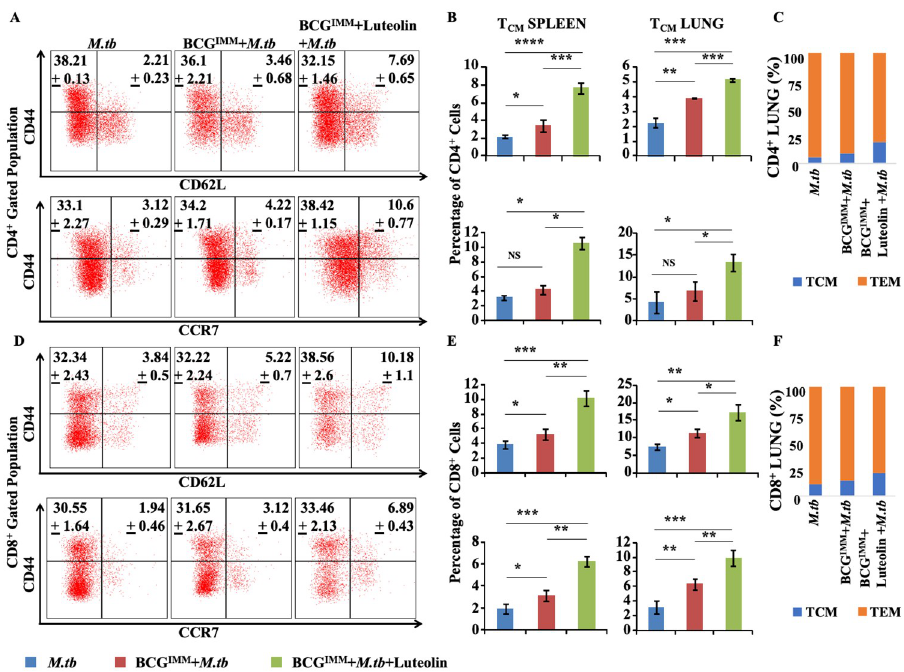
Fig 4. Luteolin induces increased T CM responses in BCG-immunized mice. (A&D) Representative FACS plots, (B, C, E and F) combined data showing memory responses in the CD4 + T cell compartment (A-C) and CD8 + T cell compartment (D-F) in spleen and lung of infected mice of the indicated study groups at 60 days post-infection. Data represented as the mean ± STDEV values from data pooled from three experiments with five mice per experiment. Differences were considered significant at P < 0.05 using one way ANOVA. � p < 0.05, �� p < 0.005, ��� p <